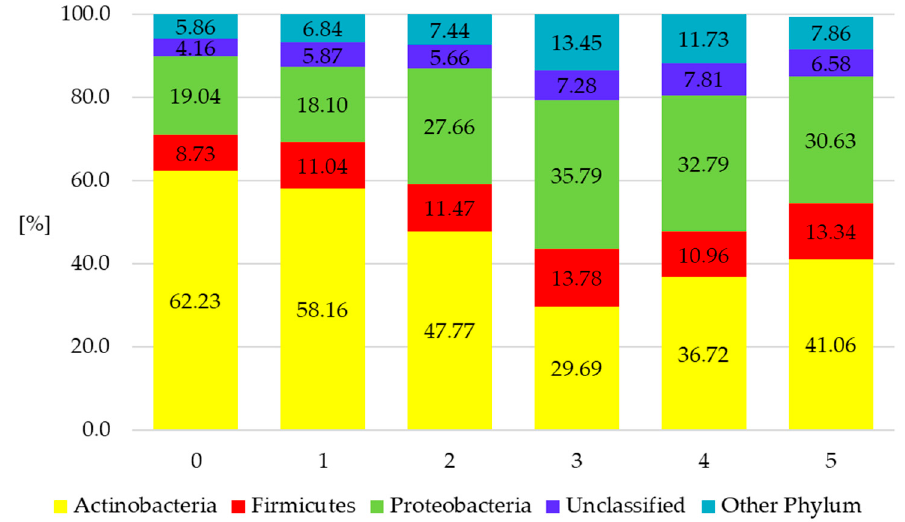
Figure 2. The composition of the structure of bacterial communities in the soil (phylum level classification interval ≥ 1% of sequences). 0—sample ‘zero’ before sowing, 1—conventional tillage (CT) before sowing spring wheat without a cover crop, 2—conventional tillage (CT) skimming before sowing the cover crop and sowing spring wheat after conventional tillage (CT), 3—skimming before sowing the cover crop and sowing spring wheat directly (no-till (NT)) into mulch, 4—sowing the cover crop directly (NT) into the stubble and then sowing spring wheat after conventional tillage (CT) and 5—sowing the cover crop directly (NT) and sowing spring wheat directly into mulch